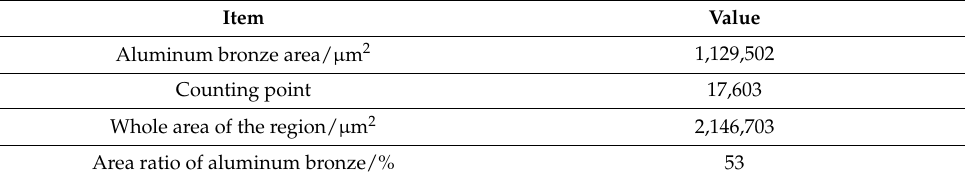
Table 3. Calculation of area ratio of aluminum bronze.